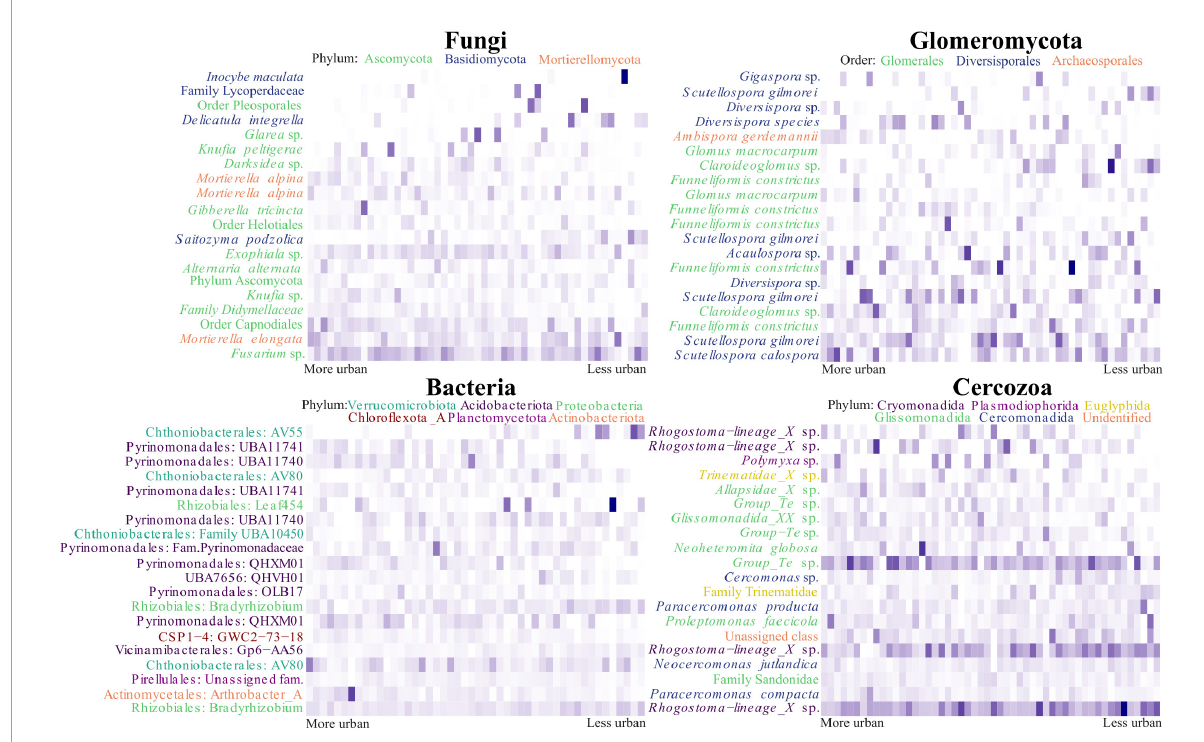
FIGURE5 Turnover of the most abundant microbial OTUs across the urbanity gradient in Berlin. The figure displays heatmaps of the top 20 most abundant OTUs within each organism group, arranged across the axis in order of principal component analysis (PCA) axis 1 score. For the fungal and Glomeromycotan OTUs, binomial annotations are included when identified. Otherwise, the highest taxonomic level attributed to the OTU is used. Labels are colored according to phylum in the fungal heatmap and according to order in the Glomeromycotan heatmap. The bacterial heatmap is annotated with the order and genus assigned to OTUs, or family if the genus was unassigned. Labels are colored according to phylum. OTUs in the Cercozoan heatmap are labeled with their binomial name, or the highest taxonomic level assigned. Labels are colored according to